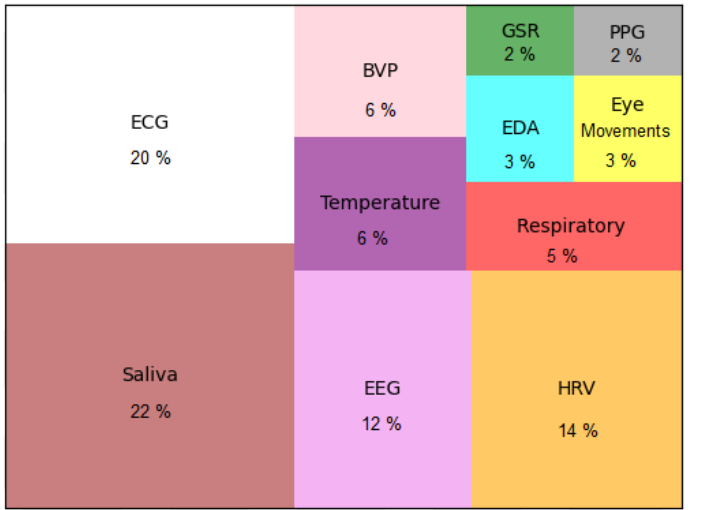
Figure 5. Types of physiological data collected in